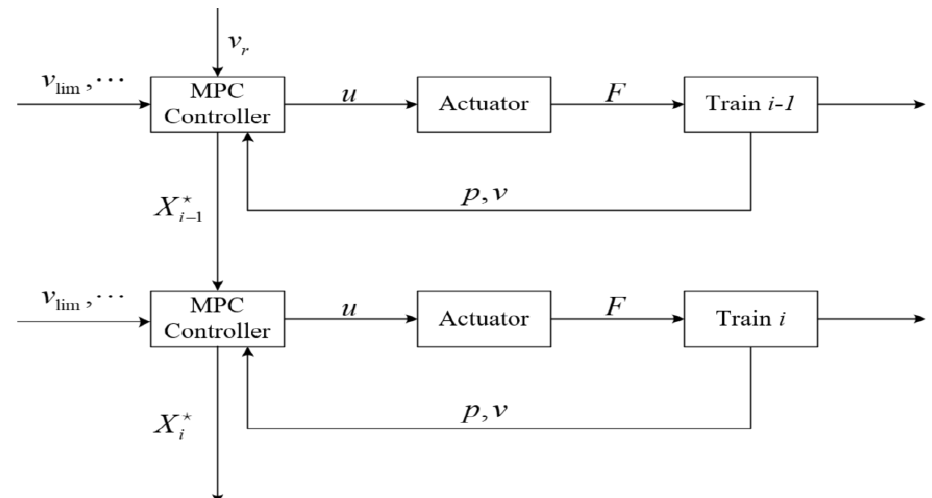
Figure 3. Serial distributed MPC control structure for two trains.